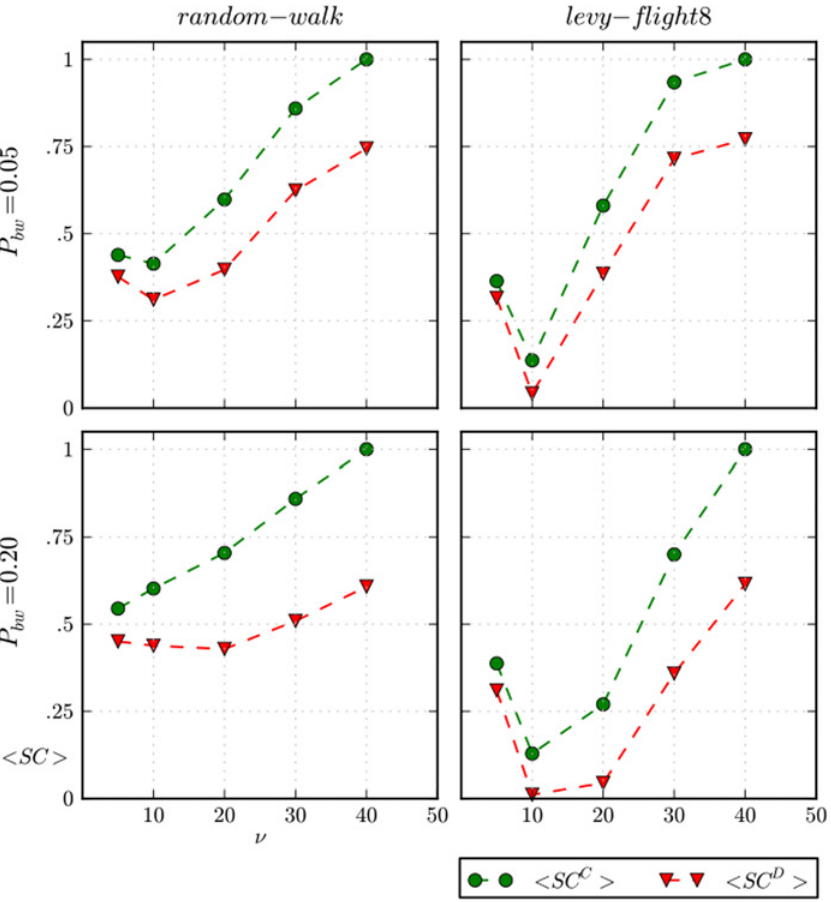
Fig 11. Average amount of social capital for cooperators and defectors. Average amount of social capital for cooperators SC C and defectors SC D over a complete simulation run for two values of P bw , and “ random-walk ” and “ Lévy-flight8 ” movements. The spatial distributions of beached whales is uniform and θ = 10 – 1 . 5 .